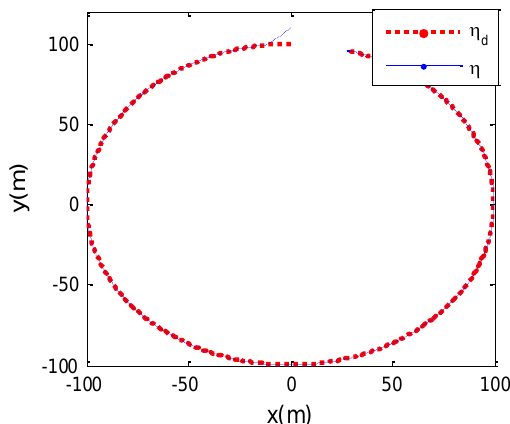
Figure 3. Trajectory tracking of AUVs using the proposed adaptive